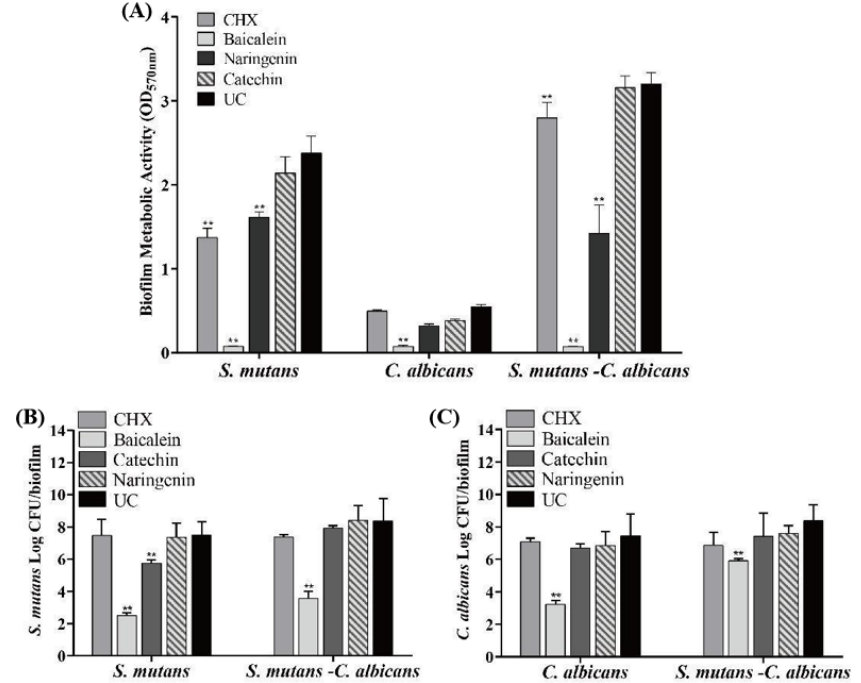
Figure 4. Antimicrobial effects of flavonoids or CHX (mean ± sd; n = 6; ** p < 0.01): ( A ) MTT metabolic activity, ( B ) S. mutans colony-forming units (CFU) in S. mutans and S. mutans - C. albicans biofilms, and ( C ) C. albicans CFU in C. albicans and S. mutans - C. albicans biofilms.